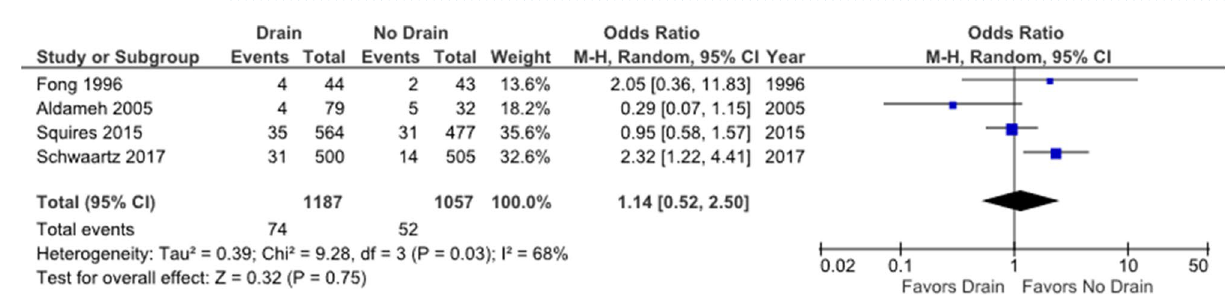
Figure 5. Forest plot of wound